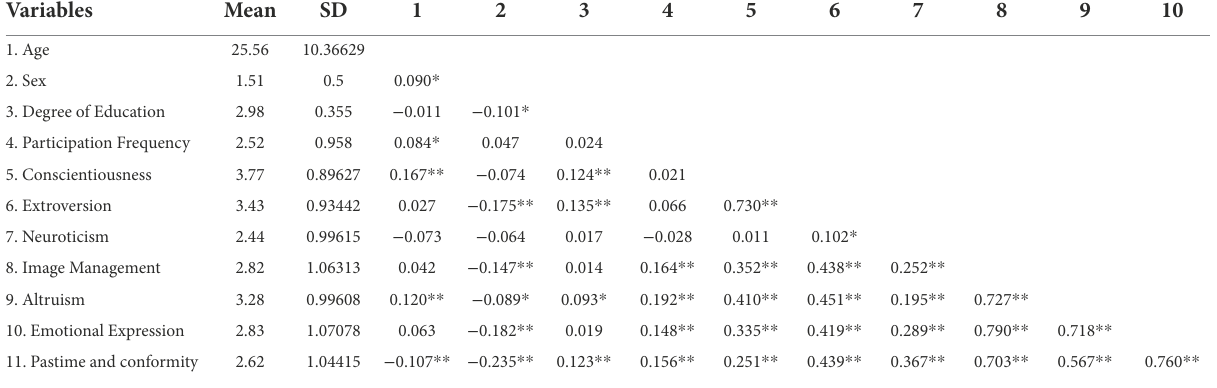
TABLE 3 Descriptive statistics and